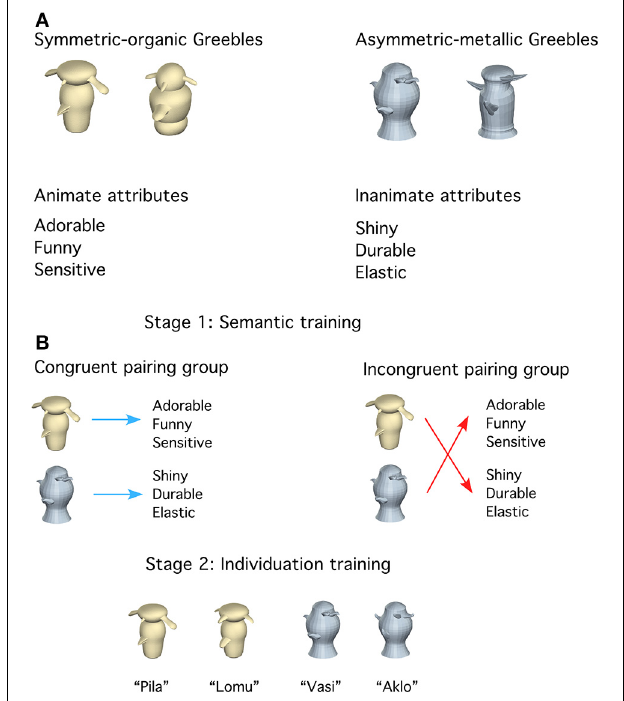
FIGURE 1 | (A) Examples of the two categories of objects and two categories of words, including Symmetric-organic objects, Asymmetric-metallic objects, animate attributes and inanimate attributes. (B) Schematic of the two-stage training. In semantic training (stage 1), participants were divided into two groups to learn to associate three words to each trained object. The two training groups differed only in terms of the pairing of the objects and words. In individuation training (stage 2), all participants learned to name and identify objects at the subordinate level quickly and